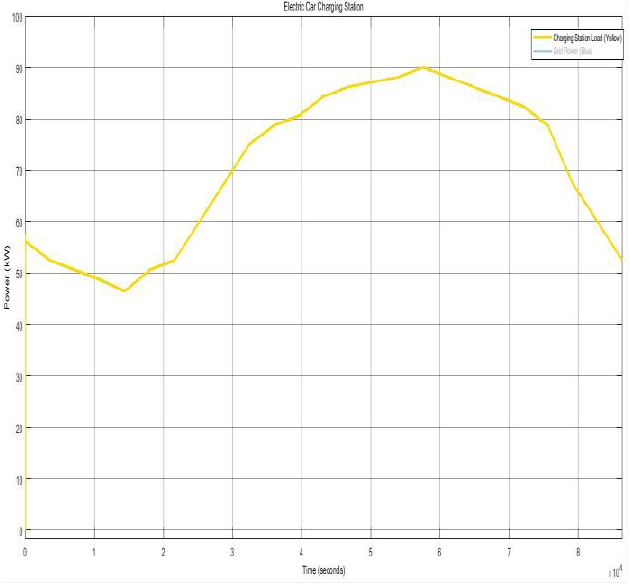
Fig. 1. Load profile of selected location